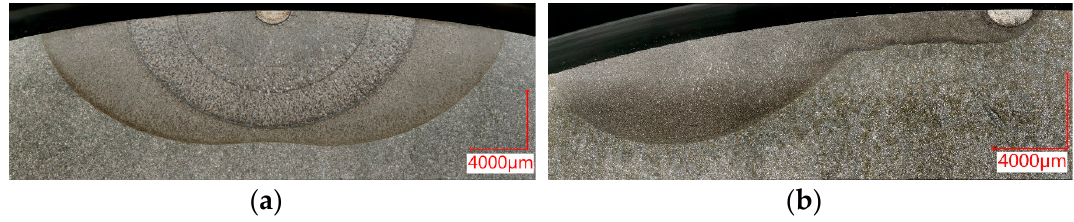
Figure 2. Examples for the deviation from semi elliptical crack front in rotating bending loaded 1:1 railway axle specimens: ( a ) Symmetrical crack growth; ( b ) Unsymmetrical crack propagation.